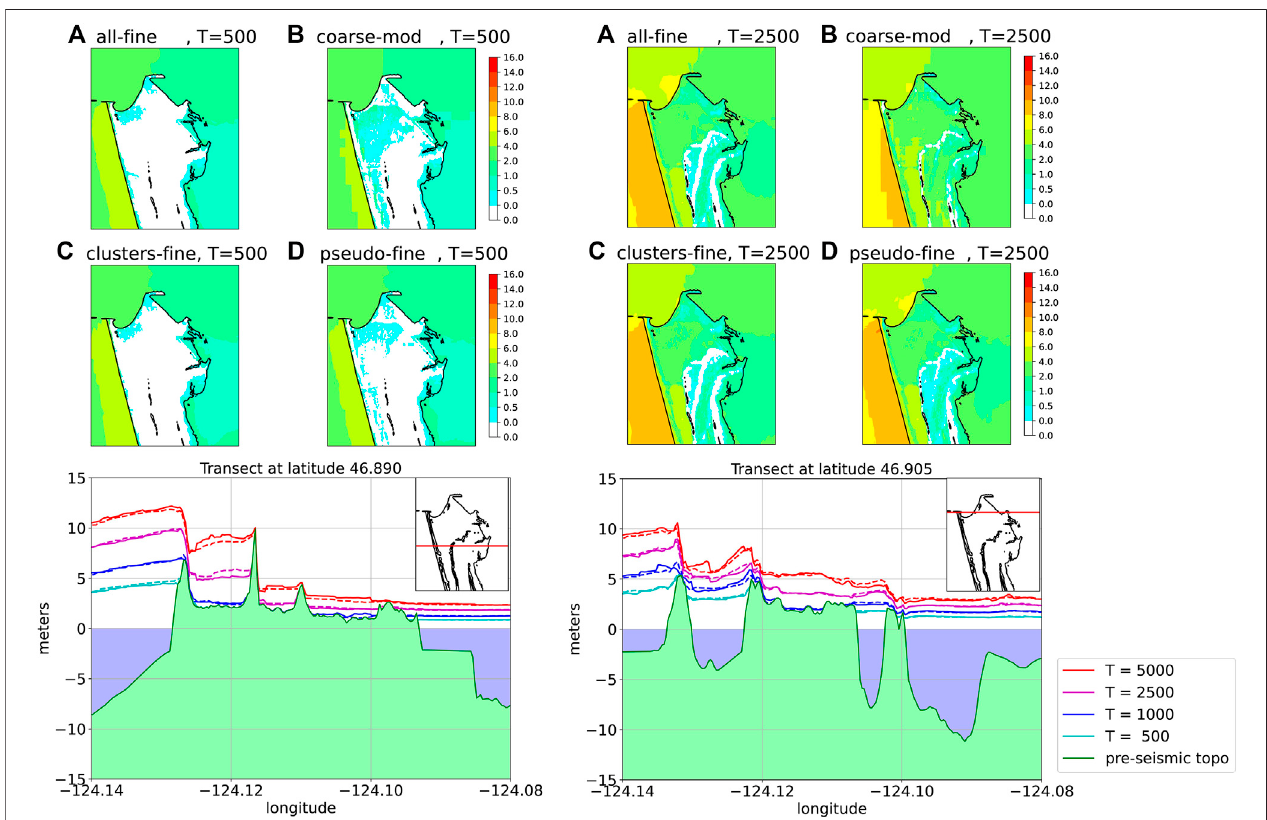
FIGURE 11 | Sample hazard maps and transects for select locations in Westport. The top panels show plan view plots for return times T (cid:2) 500 years (left) and 2,500 years (right) , over the same spatial domain as shown in Figure 3 . In each case panel (A) shows the reference all- fi ne hazard maps produced with the all- fi ne hazardcurves p f ( (cid:1) h ) , (B) showsthemapproducedwiththecoarse-modhazardcurves p cm ( (cid:1) h ) , (C) showsthemapproducedwiththeclusters- fi nehazardcurves p cf ( (cid:1) h ) , (D) showsthemapproducedwiththepseudo- fi nehazardcurves p pf ( (cid:1) h ) .Thebottom fi guresshowtransectsofthehazardmapsforfourdifferentchoicesofannual probabilities p ,correspondingtodifferentreturntimes T (cid:2) 1 / p asindicatedinthelegend.Ineachcasethedashedlineistheall- fi nereferencesolution,whilethesolidline is the approximation generated using 18 clusters and the pseudo- fi ne improvements of the other coarse-grid runs.